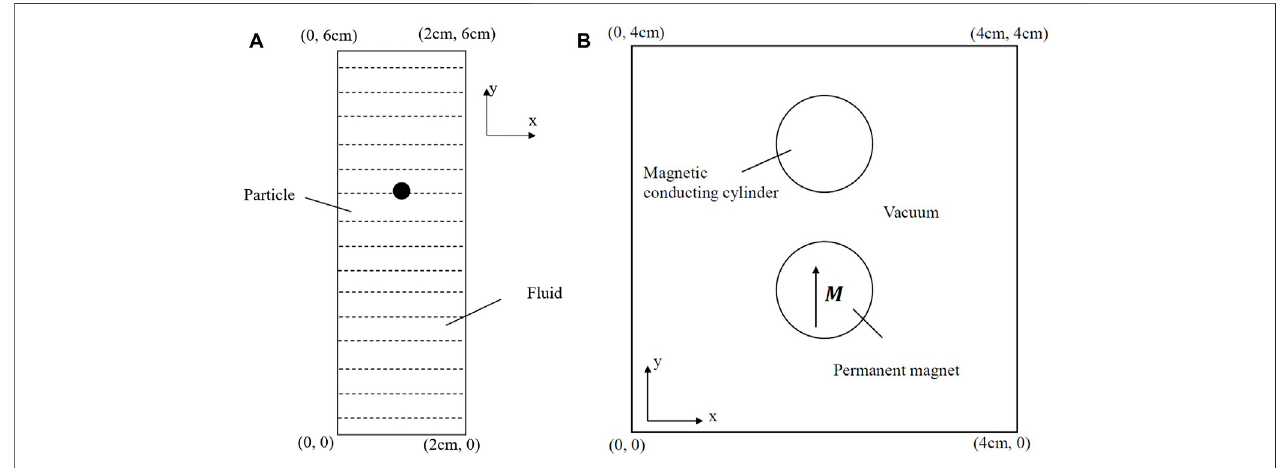
FIGURE 4 | Model of free settlement of a single particle (A) . Model of permanent magnet attracting magnetic conducting cylinder (B) .